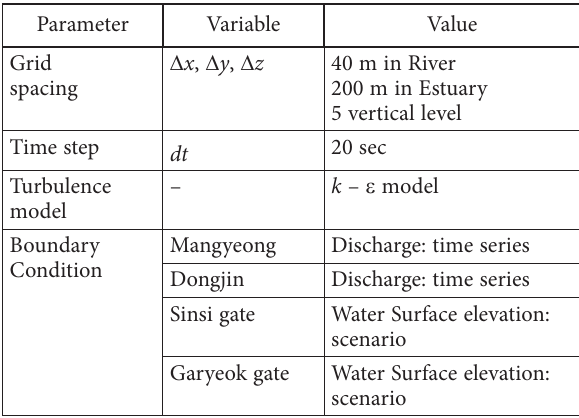
Table 7. The numerical